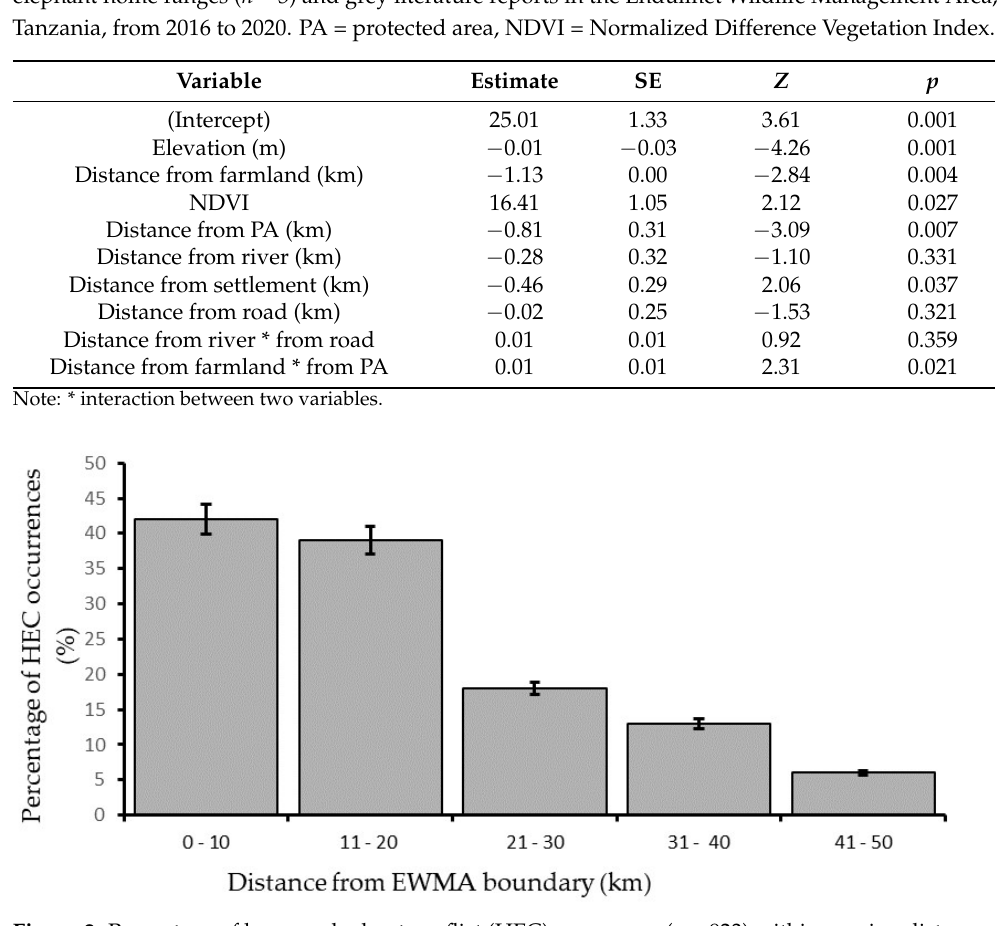
Figure 2. Percentage of human-elephant conflict (HEC) occurrence ( n = 923) within varying distances from 0 Enduimet Wildlife Management Area (EWMA) boundary (in km), as reported be-